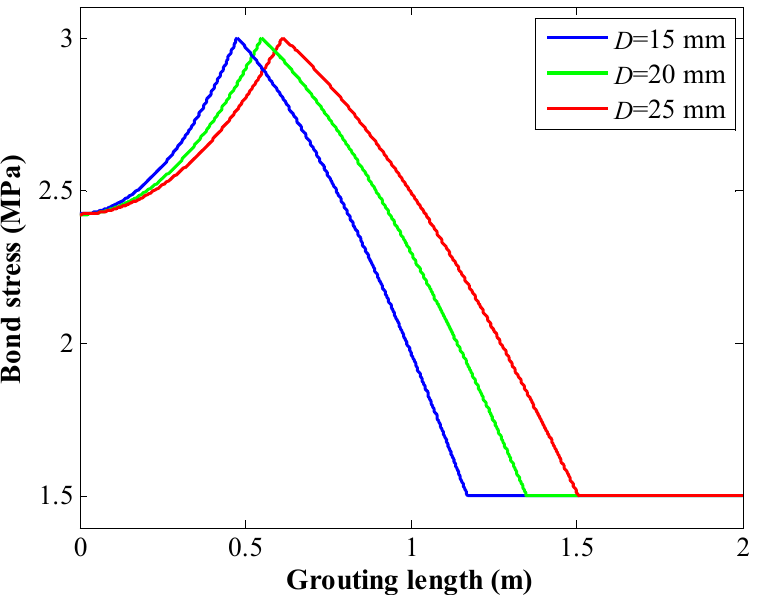
Figure 5. Effect of bar diameter on the bond stress distributing on the boundary surface when peak load occurred.